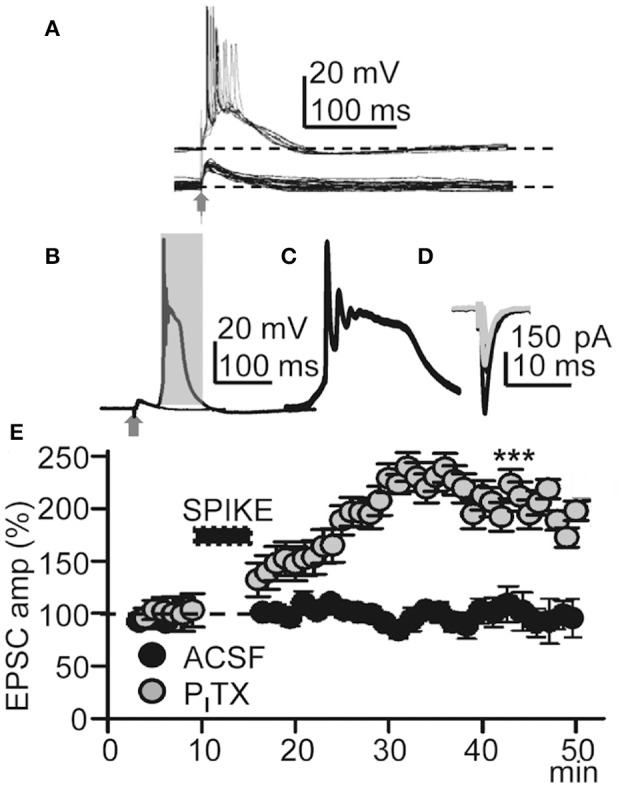
Repeated Ca2+ spikes induce LTP. (A) Representative superimposed EPSPs recorded in control ACSF (bottom) and superimposed EPSP-Ca2+ spikes (n = 20) recorded under PITX (50 μM) (top); note AP bursts. (B) Superimposed averaged EPSP and EPSP-Ca2+ spike (n = 20 as in all other Figures) recorded under PITX. (C) Expanded time record taken from the shaded area in (B). (D) Representative superimposed averaged EPSCs recorded before and ≈30 min after LTP induction (gray and black records, respectively). (E) Time course of the peak EPSC amplitude (% of controls, as in all other Figs.) in ACSF (black circles, N = 8, P > 0.05) and under PITX (gray circles, N = 10, P < 0.001).